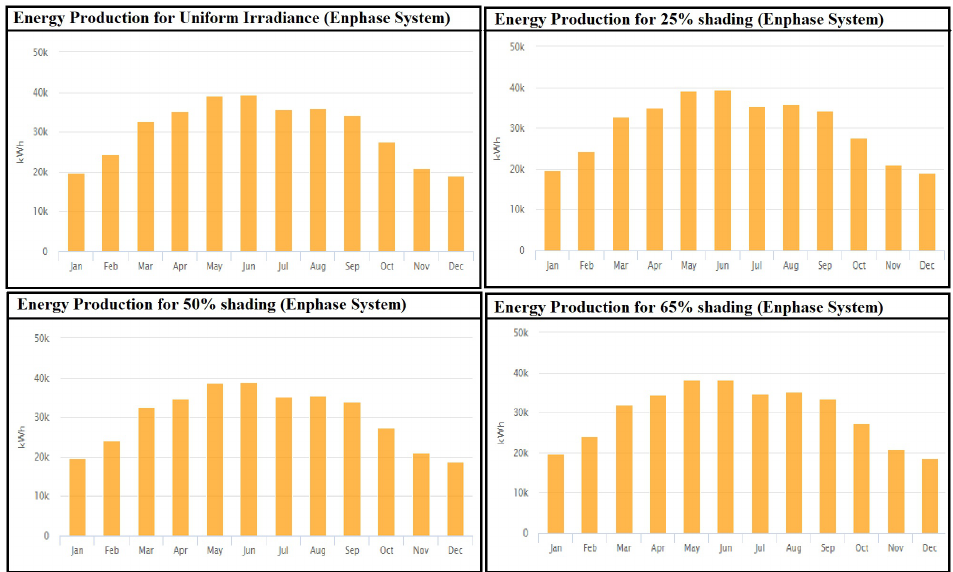
Figure 46. Results of energy production of Enphase inverter on different shading conditions using Helioscope.